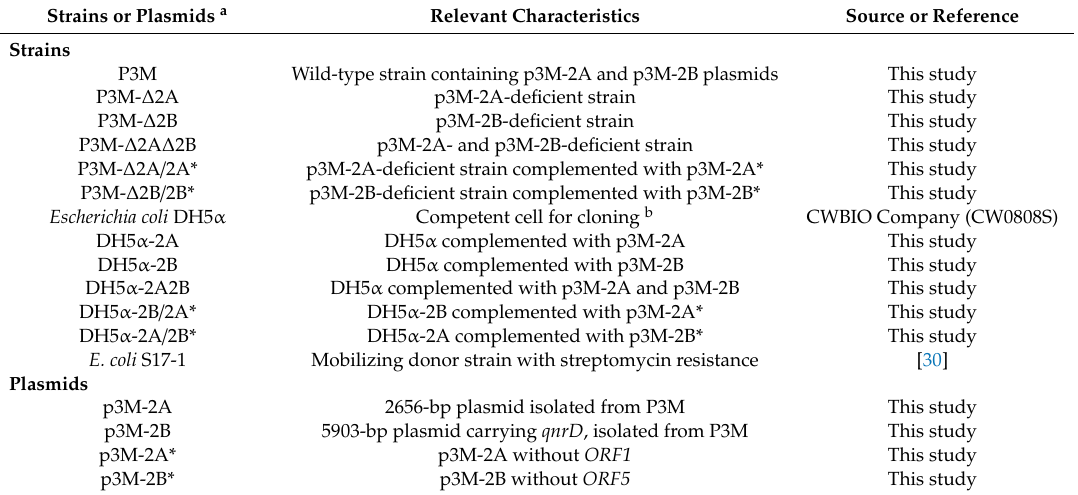
Table 1. Strains and plasmids used in this study. P3M, Proteus vulgaris strain 3M. Strains or Plasmids